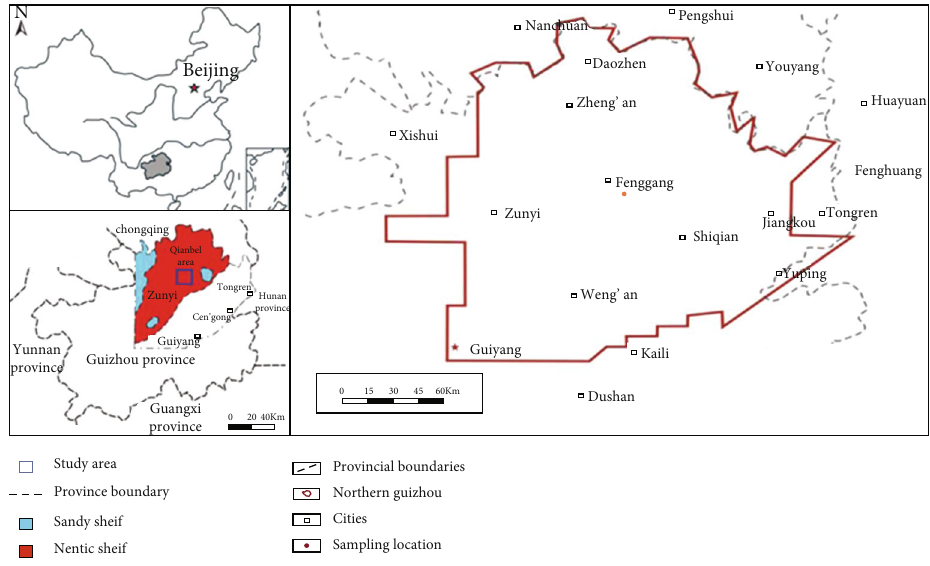
Figure 1: Detailed location map of the third district of the Feng ’ gang No. 3 block, Guizhou